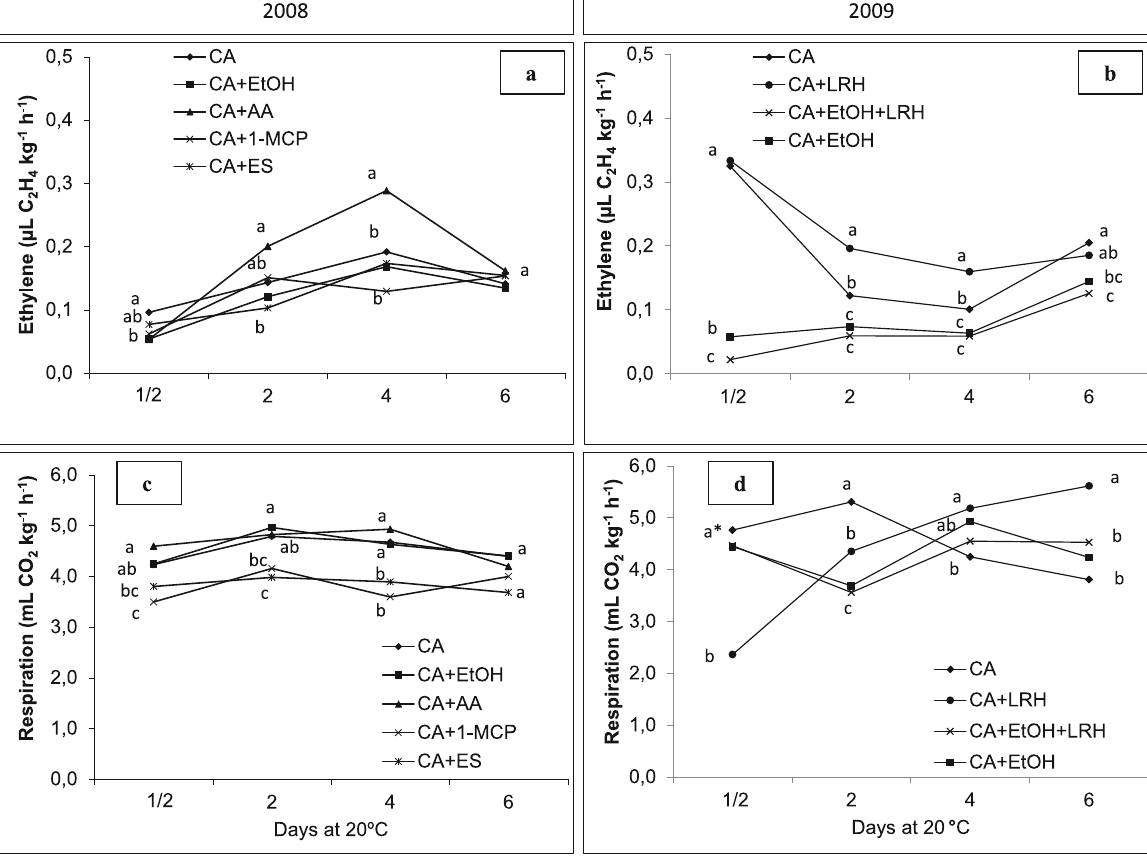
Figure 1 - Ethylene production ( a and b , for the experiments of 2008 and 2009, respectively) and respiratory rate ( c and d for the experiments of 2008 and 2009, respectively) of ‘Royal Gala’ apples stored for 8 months and then exposed during 6 days at 20 °C. * Treatments with means not followed by the same lowercase letter in the same evaluation date differ by Tukey’s test at 5% probability. Initial analysis: ethylene: 1.33 μ L C H kg -1 h -1 , respiration: 6.86 mL CO kg -1 h -1 for the experiment I and for 2 4 2